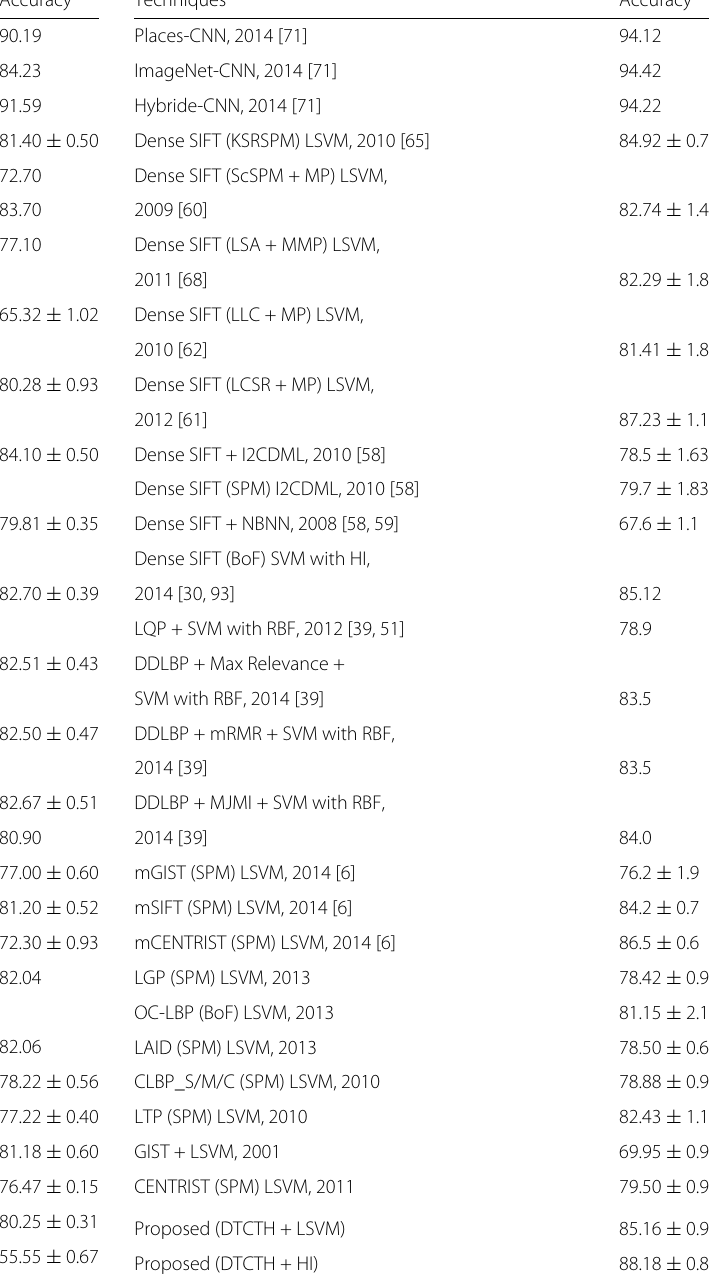
Table 7 Scene classification rate (%) in Scene 15 Table 8 Event classification rate (%) in UIUC Sports